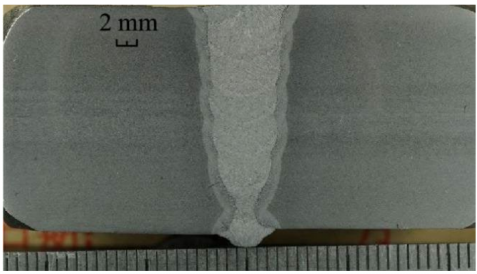
Figure 7. Macro metallographic